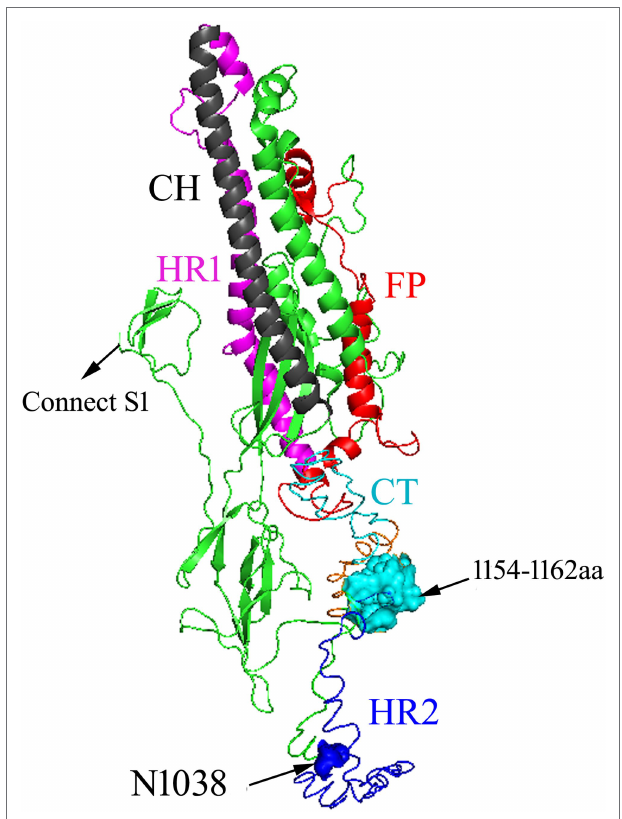
FIGURE 7 | Schematic illustration of zy30 S2 protein drawn by comparison with the corresponding sequence of the M41 strain. FP: fusion peptide. HR1: heptad repeats 1. CH: central helix. HR2: heptad repeats 2. The range of FP was not determined. The HR2 was disordered. Amino acid residues at 1038 aa (blue) and 1,154–1,162 aa